Question: Express in one sentence what the figure is showing.
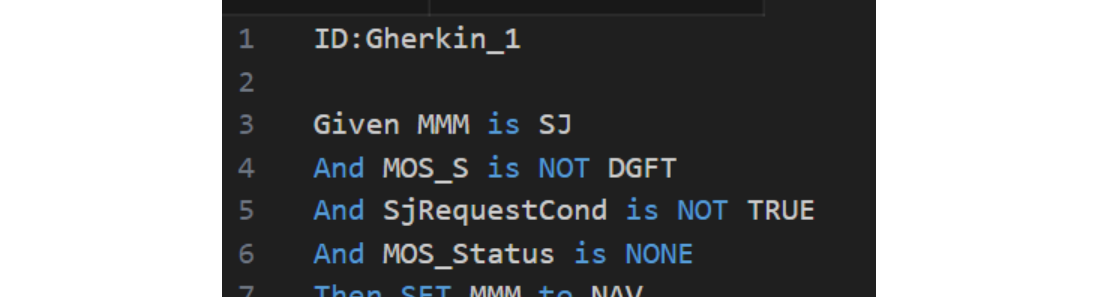
Answer: A requirement written in customized version of the Gherkin    To systematically analyze the contradictions between requirements, we started the process by  creating a dataset. Within these datasets, requirements were rigorously parsed based on the  grammars associated with their respective formats. This parsing process was facilitated using  ANTLR4 (ANother Tool for Language Recognition), a versatile parser known for its ability to  create parsers for various programming languages and data formats [17].